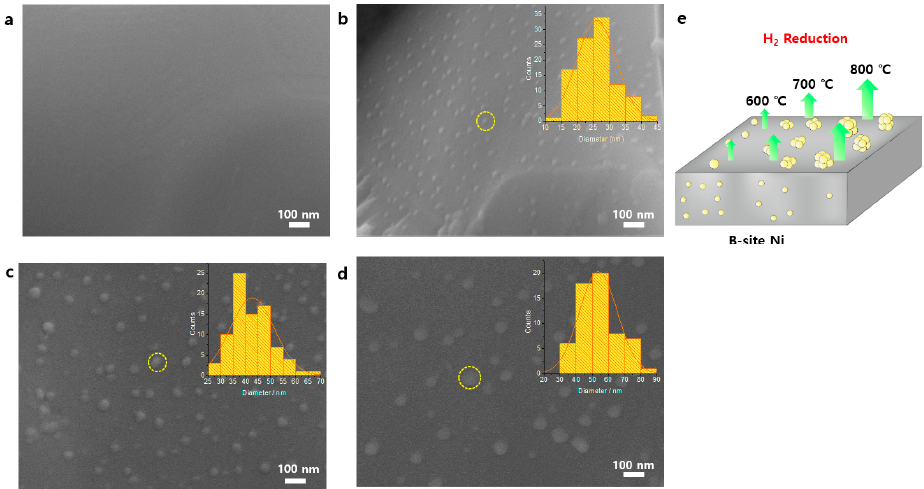
Figure 2. SEM images (inset: particle size distribution) of ( a ) LCTN, ( b ) LCTN-R6, ( c ) LCTN-R7, ( d ) LCTN-R8, and ( e ) the expected exsolution mechanism.